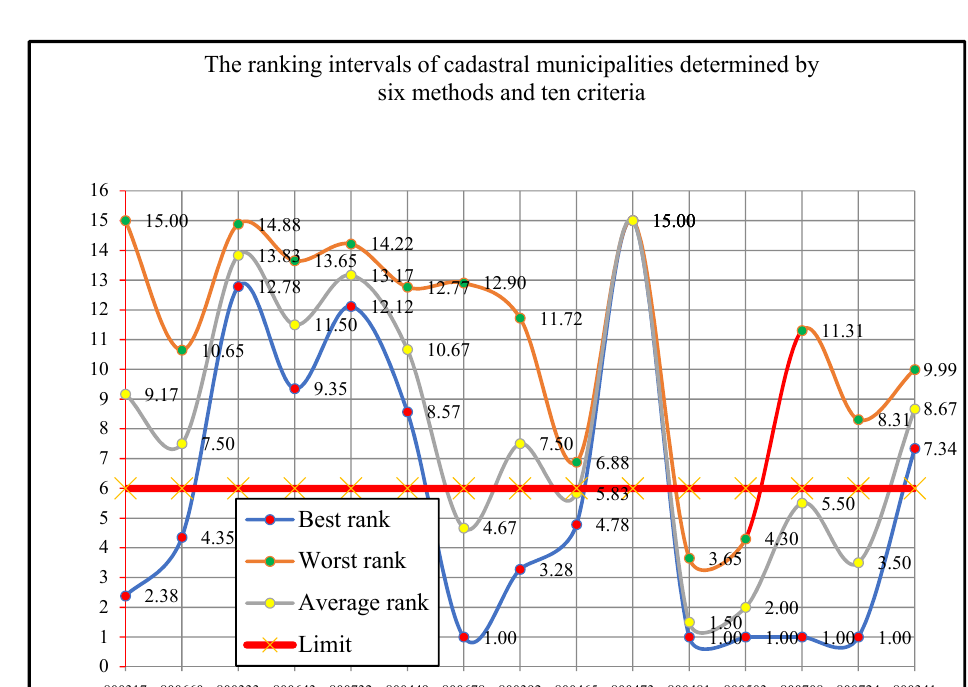
Figure 2. The ranking interval of cadastral municipalities with eight criteria.